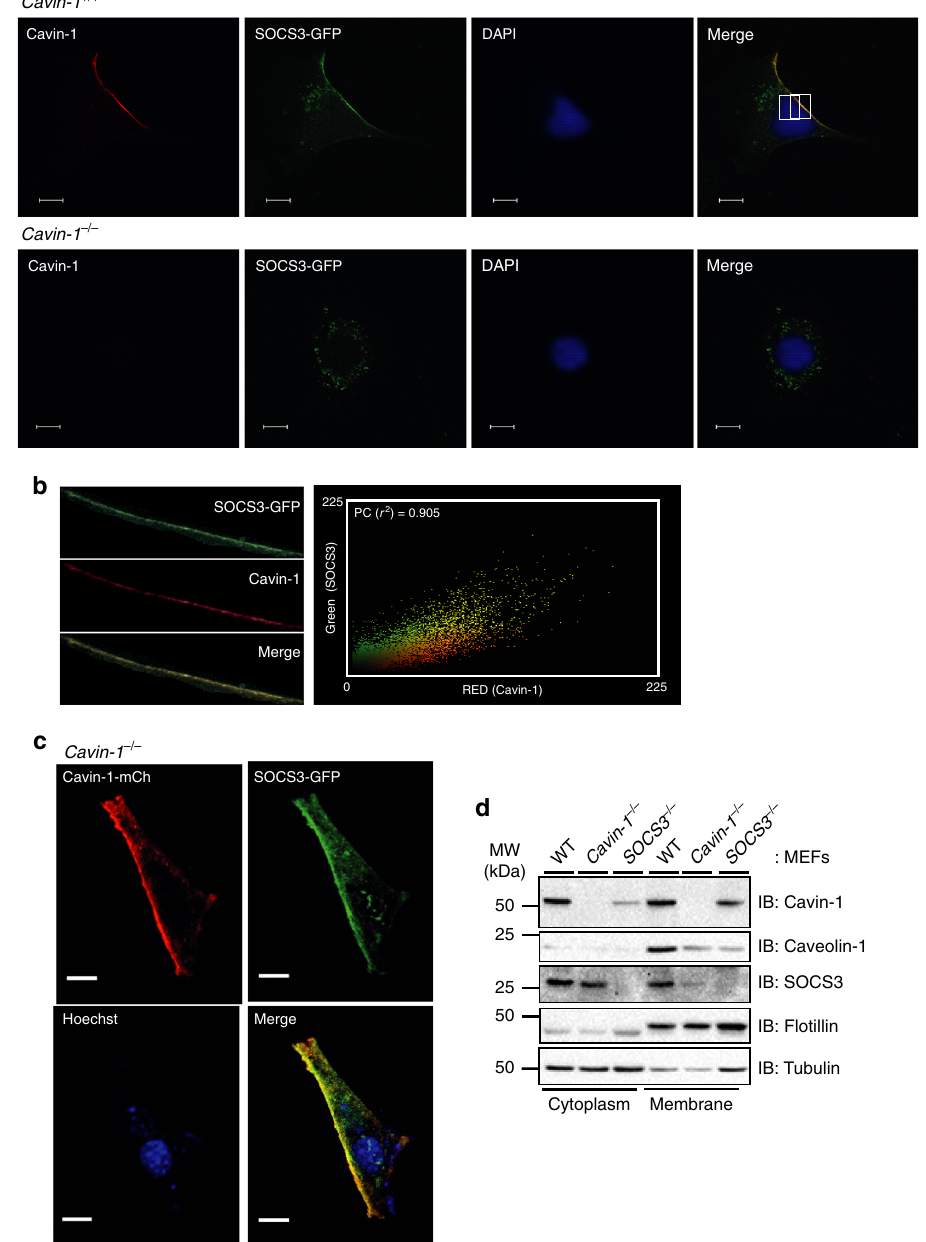
Fig. 7 Cavin-1 drives SOCS3 localisation to the plasma membrane. a WT ( cavin-1 + / + ) and cavin-1 − / − MEFs transiently expressing SOCS3-GFP (green) were stained with DAPI prior to being fi xed, solubilised, and stained with anti-cavin-1 antibody (red) before mounting for imaging by confocal microscopy. Areas of red and green overlap are yellow. Scale bar = 10 μ m. b Pearson's correlation coef fi cient value ( r 2 ) measured from the intensity values located within the rectangular region on the plasma membrane superimposed on the merged cavin-1/SOCS3-GFP image from WT MEFs. c Cavin-1 − / − MEFs transiently co- expressing SOCS3-GFP (green) and cavin-1-mCh (red) were stained with Hoechst 33342 prior to being fi xed for imaging by confocal microscopy. Areas of red and green overlap are yellow. Scale bar = 10 μ m. d WT, SOCS3 − / − , and cavin-1 − / − MEFs were pre-incubated with Fsk (50 μ M) for 5 h to induce SOCS3 prior to subcellular fractionation and analysis by SDS-PAGE and immunoblotting with the indicated